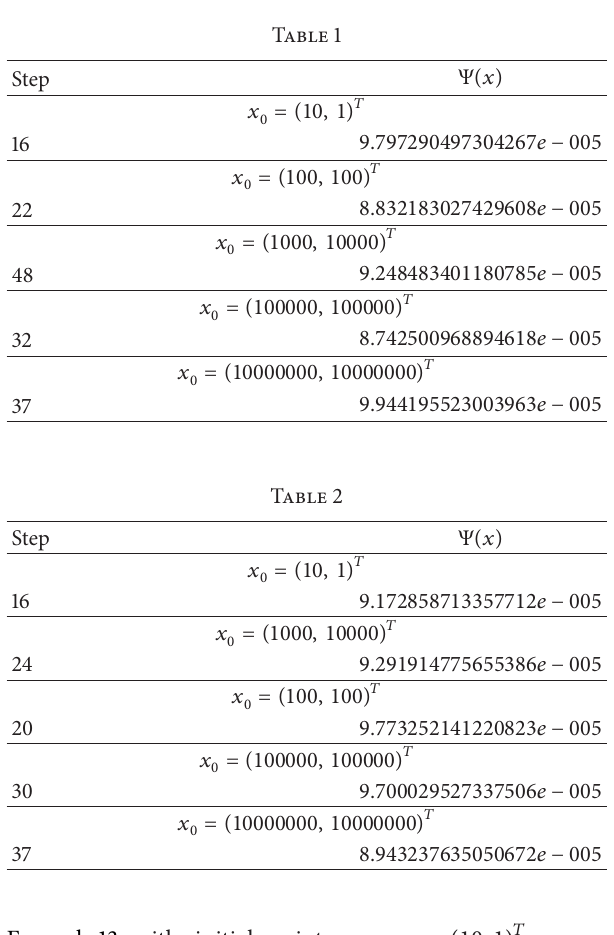
Discussion 1. From the numerical results for Method 1